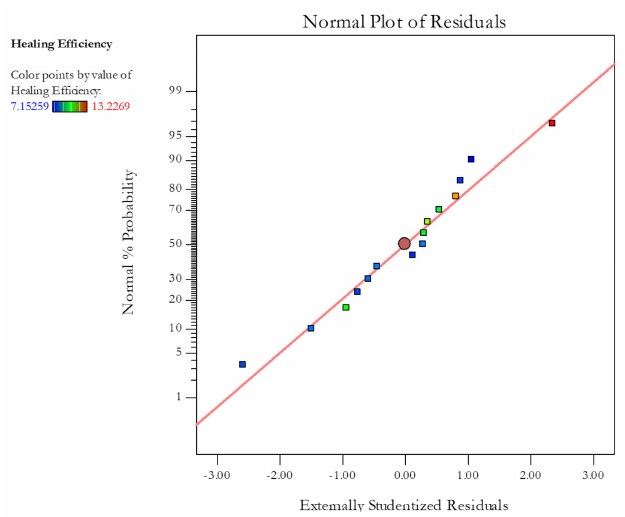
Figure A2. Normal plot of the residuals.